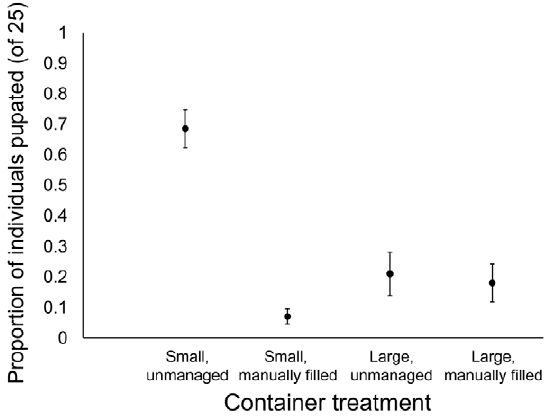
Figure 5. Standardized pupation probability by container type. Mean ( 6 SE) proportion of larvae from laboratory families that pupated during the experiment. Proportions were calculated by genotyping all collected pupae to identify those originating from laboratory families (25 F 1 first instars introduced into each container). Data came from eight houses during the first trial.